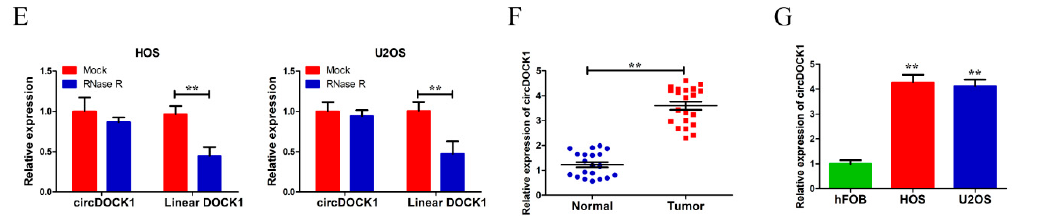
Figure 1. CircDOCK1 is highly expressed in OS tissues and cells. ( A ) CircRNAs are expressed differently between OS and healthy paracarcinoma tissues. ( B ) The expressions of top three upregulated circRNAs in OS cell lines. ( C ) Sanger sequencing validated the back splice junction of circDOCK1. ( D ) PCR products of circDOCK1 in agarose gel electrophoresis. ( E ) CircDOCK1 was stable after RNase R treatment. ( F ) CircDOCK1 expression in OS samples. ( G ) The expression of circDOCK1 in OS cell lines. * p < 0.05, ** p < 0.01.